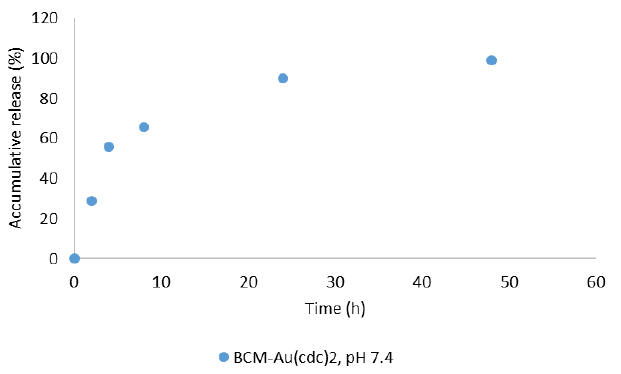
Figure 5. In vitro [Au(cdc) 2 ] − release profile for BCM-[Au(cdc) 2 ] at pH 7.4.